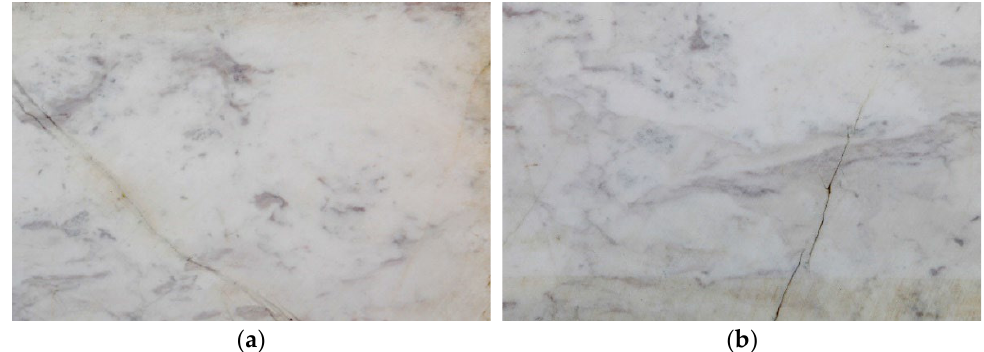
Figure 4. ( a ) Textured marble without cracks. The line resembling a crack at the left–bottom section of the image is a fissure; ( b ) textured marble with cracks. Two parallel cracks at the right–bottom section of the image. Both depicted marble samples have not been treated with any resin.